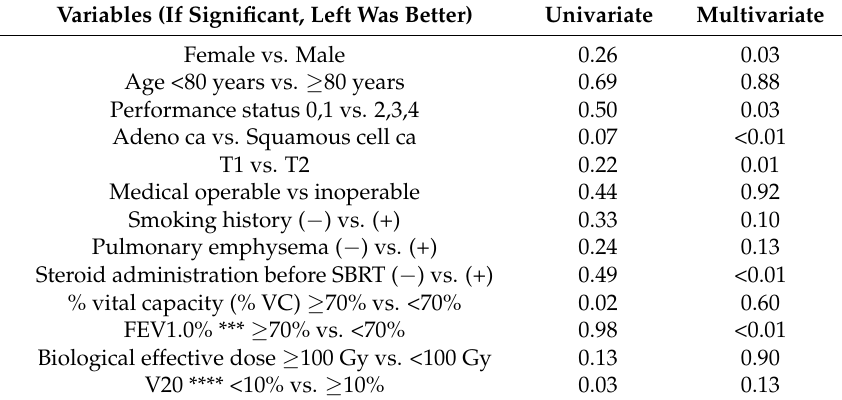
Table 2. Univariate * and multivariate ** analysis for OS ( p value).